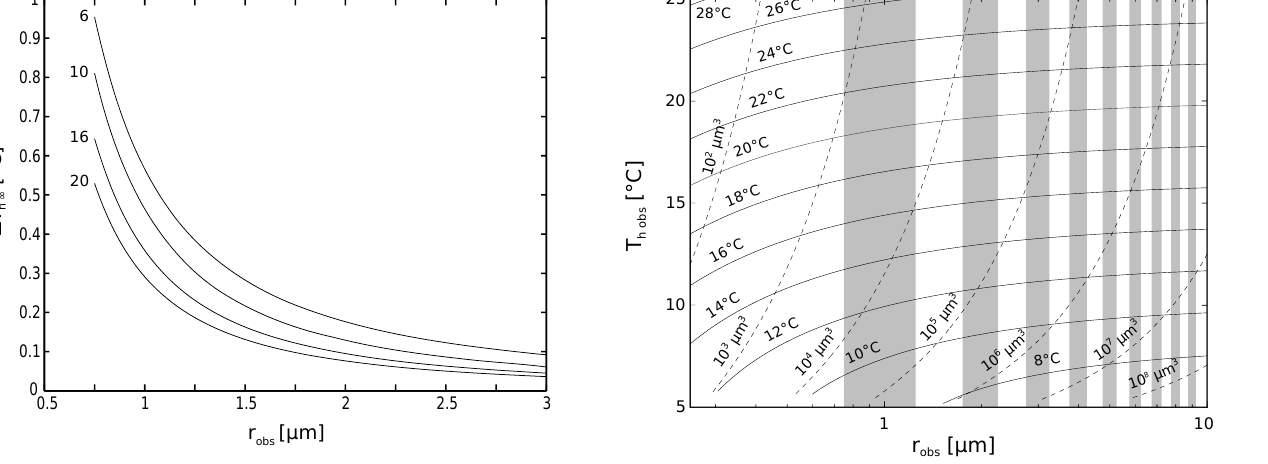
Figure 5. Dependence of the inclusion volume (dashed lines) and T h ∞ (solid lines) on T hobs and r obs . Grey bars indicate a radius measurement error of ±